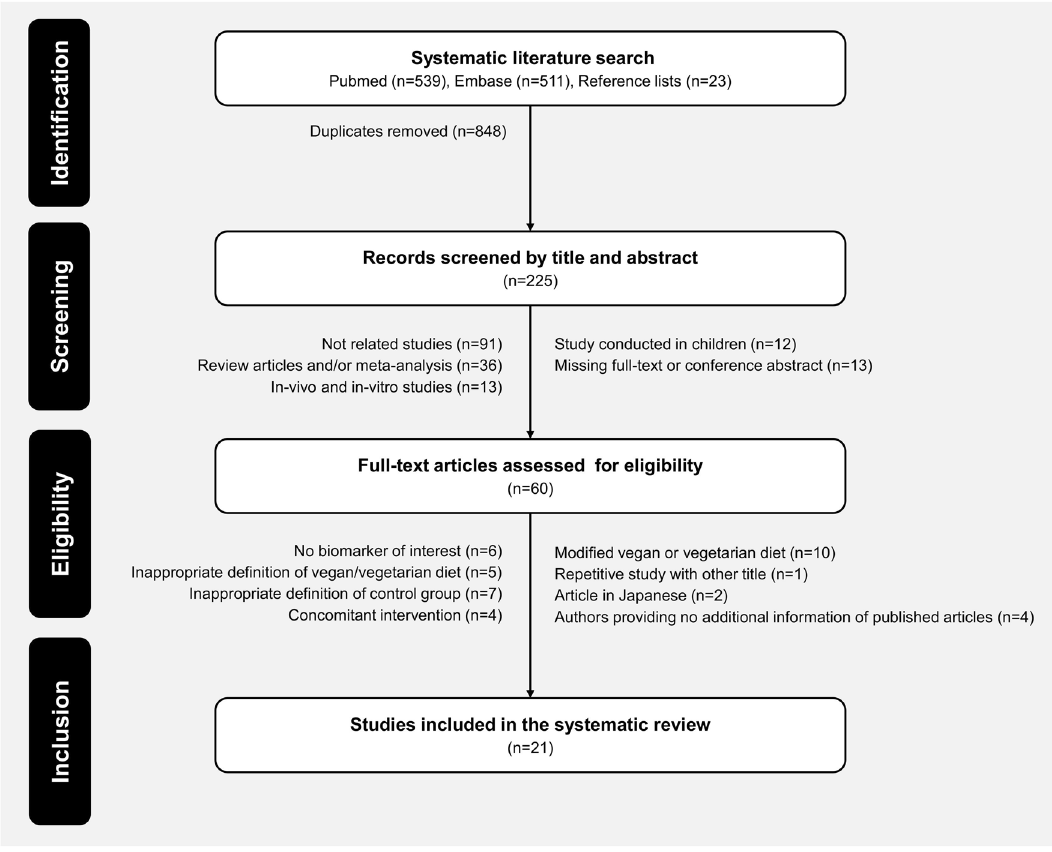
Figure 1. Flowchart. Selection process from initial search to final number of the included